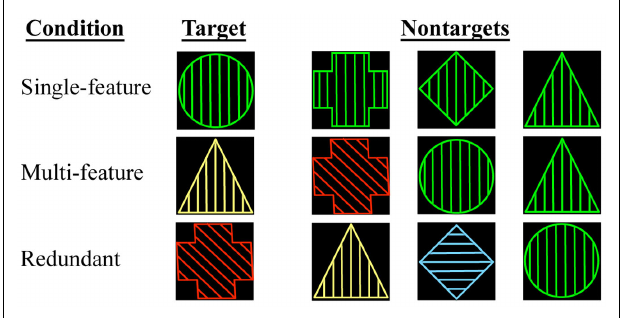
FIGURE 1 | Depiction of the single-feature, multi-feature, and redundant reaction time conditions. For each condition, examples of a Target and of Non-targets are shown where